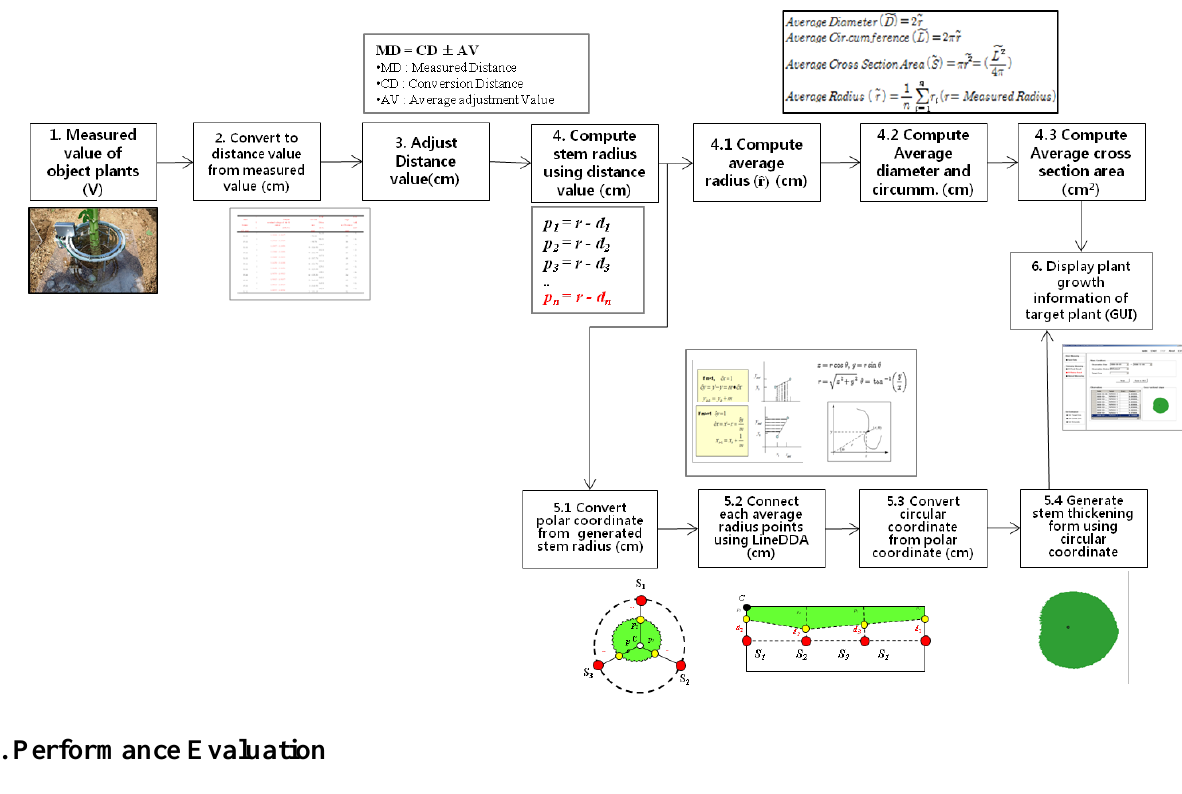
Figure 21. Process of generation of the plant growth information using the measured data.